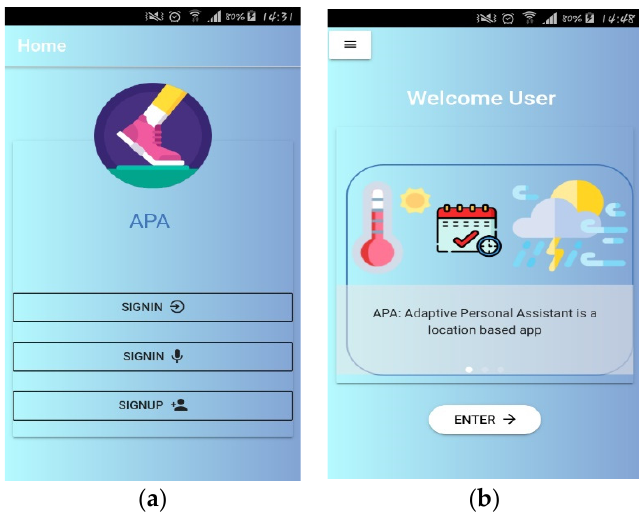
Figure 8. APA prototype screenshots. ( a ) home landing page, ( b ) welcome